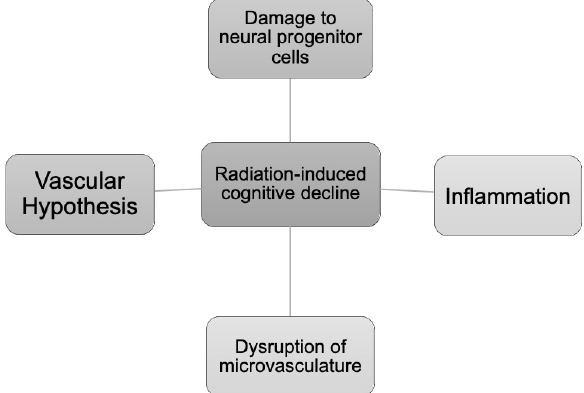
Figure 2. Potential mechanisms in radiation-induced cognitive decline and the role of